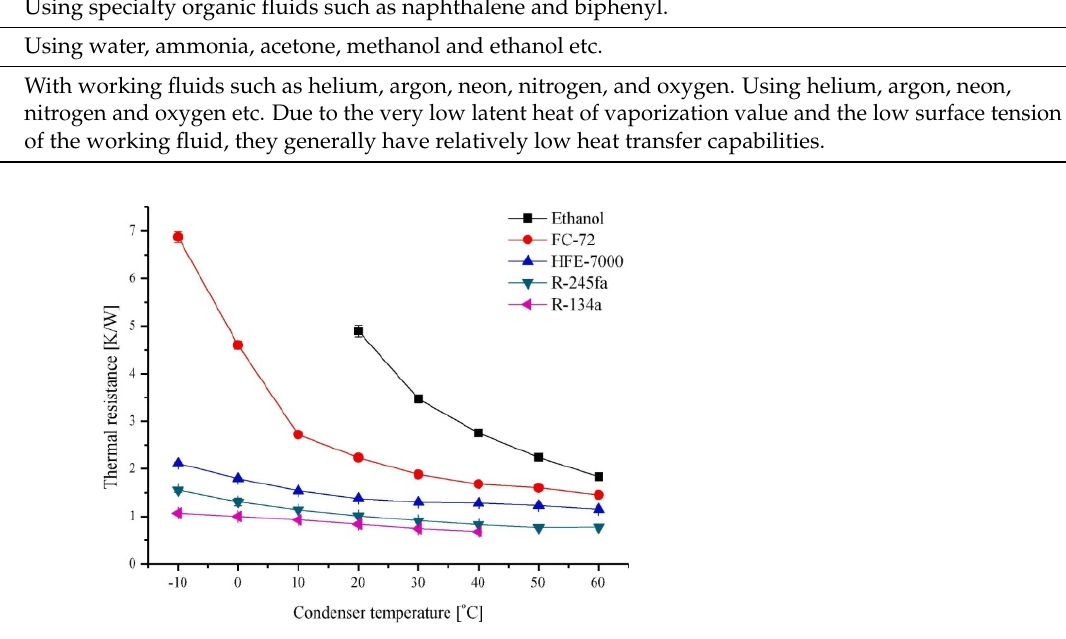
Figure 5. Comparison of the thermal resistance of MPHP for different working fluids [33].